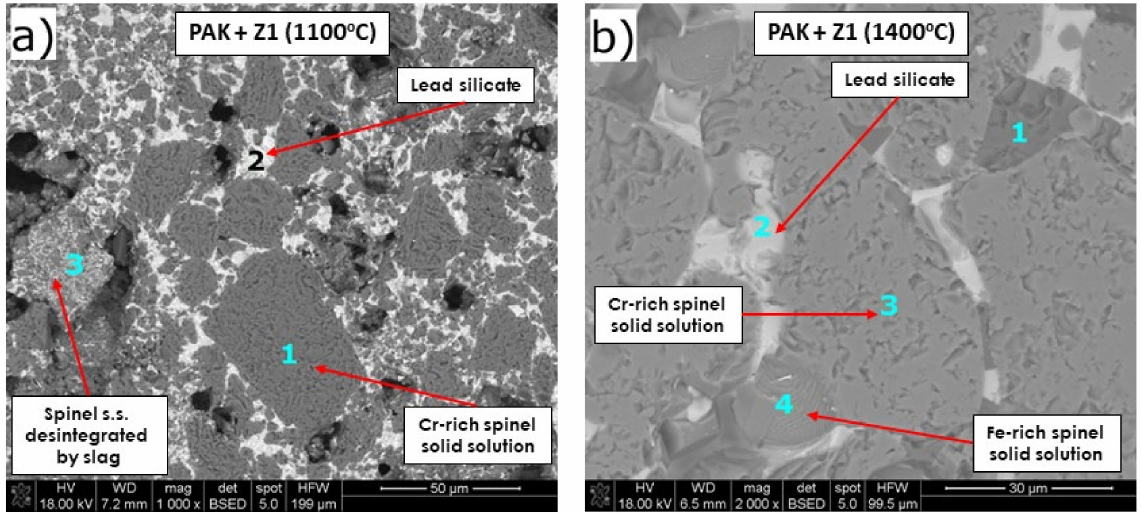
Figure 9. SEM images of PAK after pellet test at 1100 ◦ C ( a ) and 1400 ◦ C ( b ). Table 8. EDS analysis in microareas of mixture PAK + slag after corrosion, in the points marked in Figure 9, together with corresponding phases. Figure No.